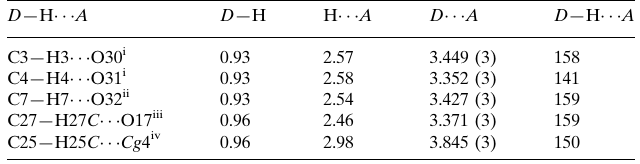
Hydrogen-bond geometry (A˚ , (cid:3) ).